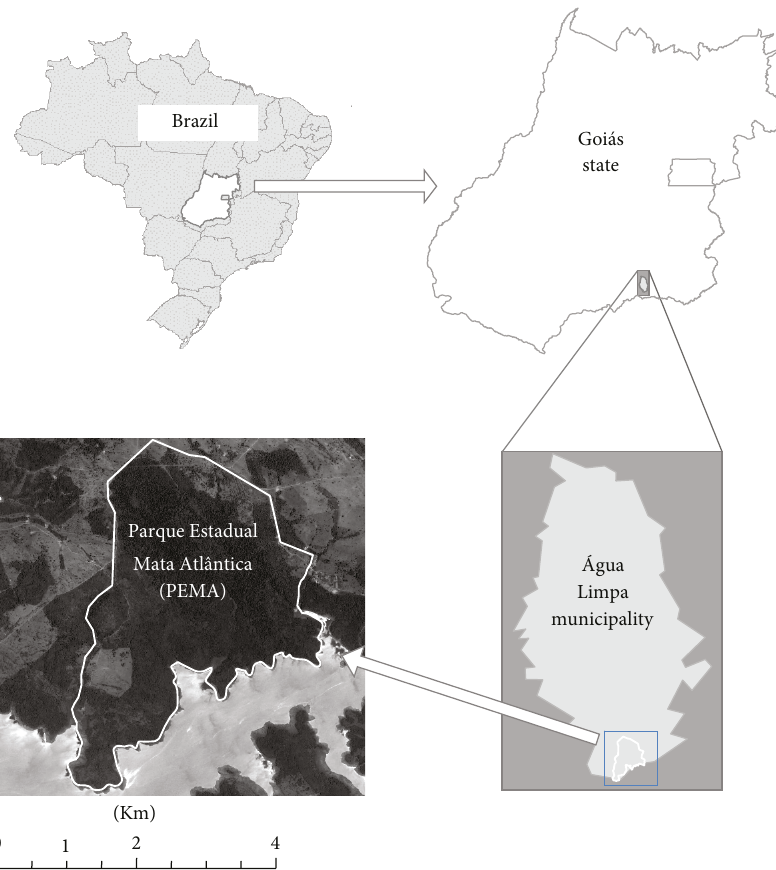
Figure 1: Parque Estadual Mata Atlˆantica (PEMA) in ´Agua Limpa municipality, Goi´as state, Brazil. Satellite image: Google Earth, 2016.